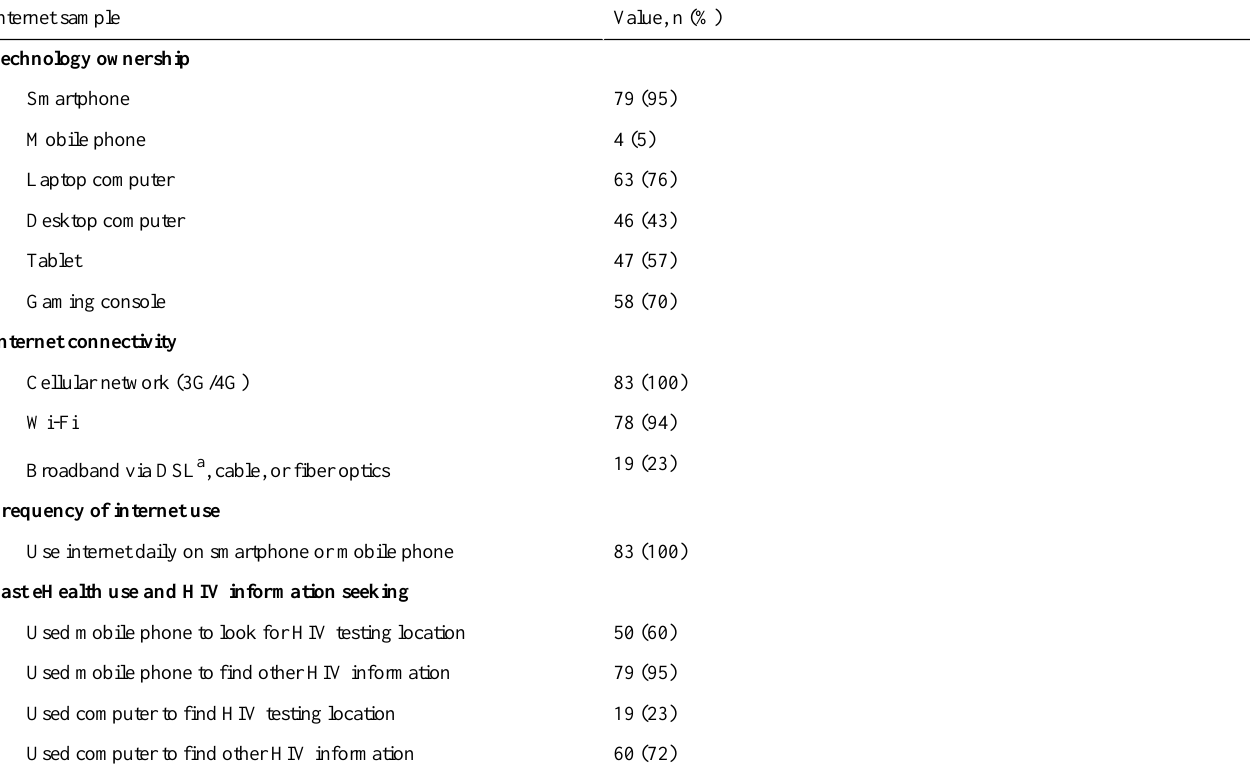
Table 2. Technology ownership and use—internet sample